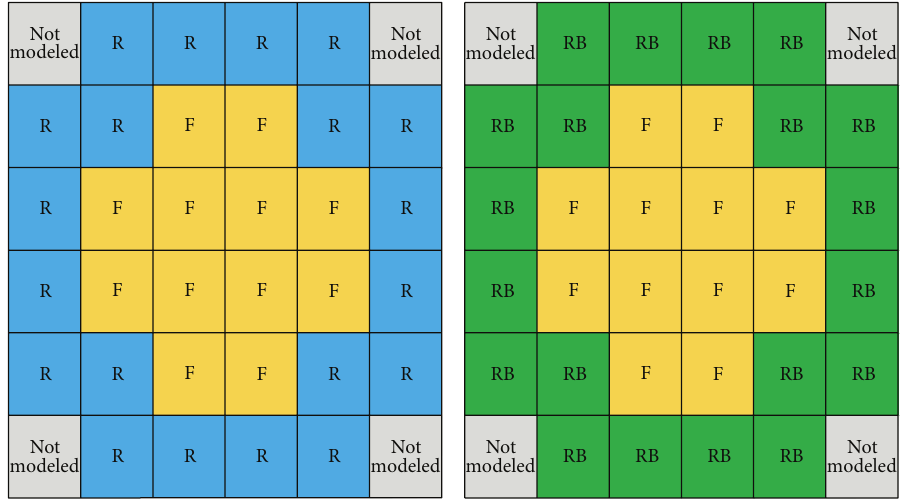
Figure 7: Nodal models for DIMPLE S06 two-step calculation.